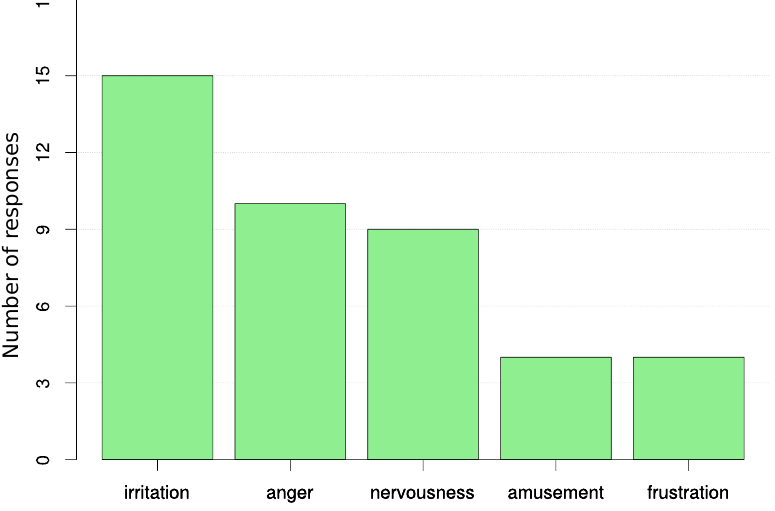
Figure 7. Negative emotions induced by the malicious behaviour of the integrated development environment (IDE).